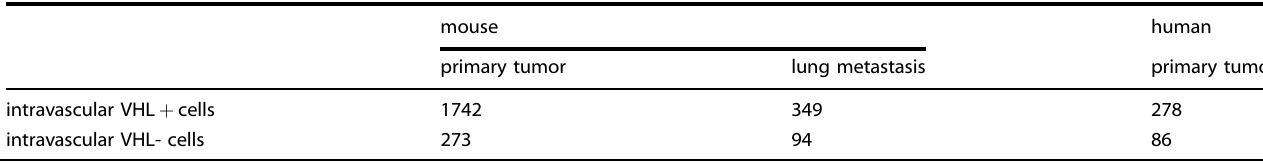
Table 2. VHL positivity in intravascular tumor cells (RENCA mixed tumor and human primary tumor, #22) mouse